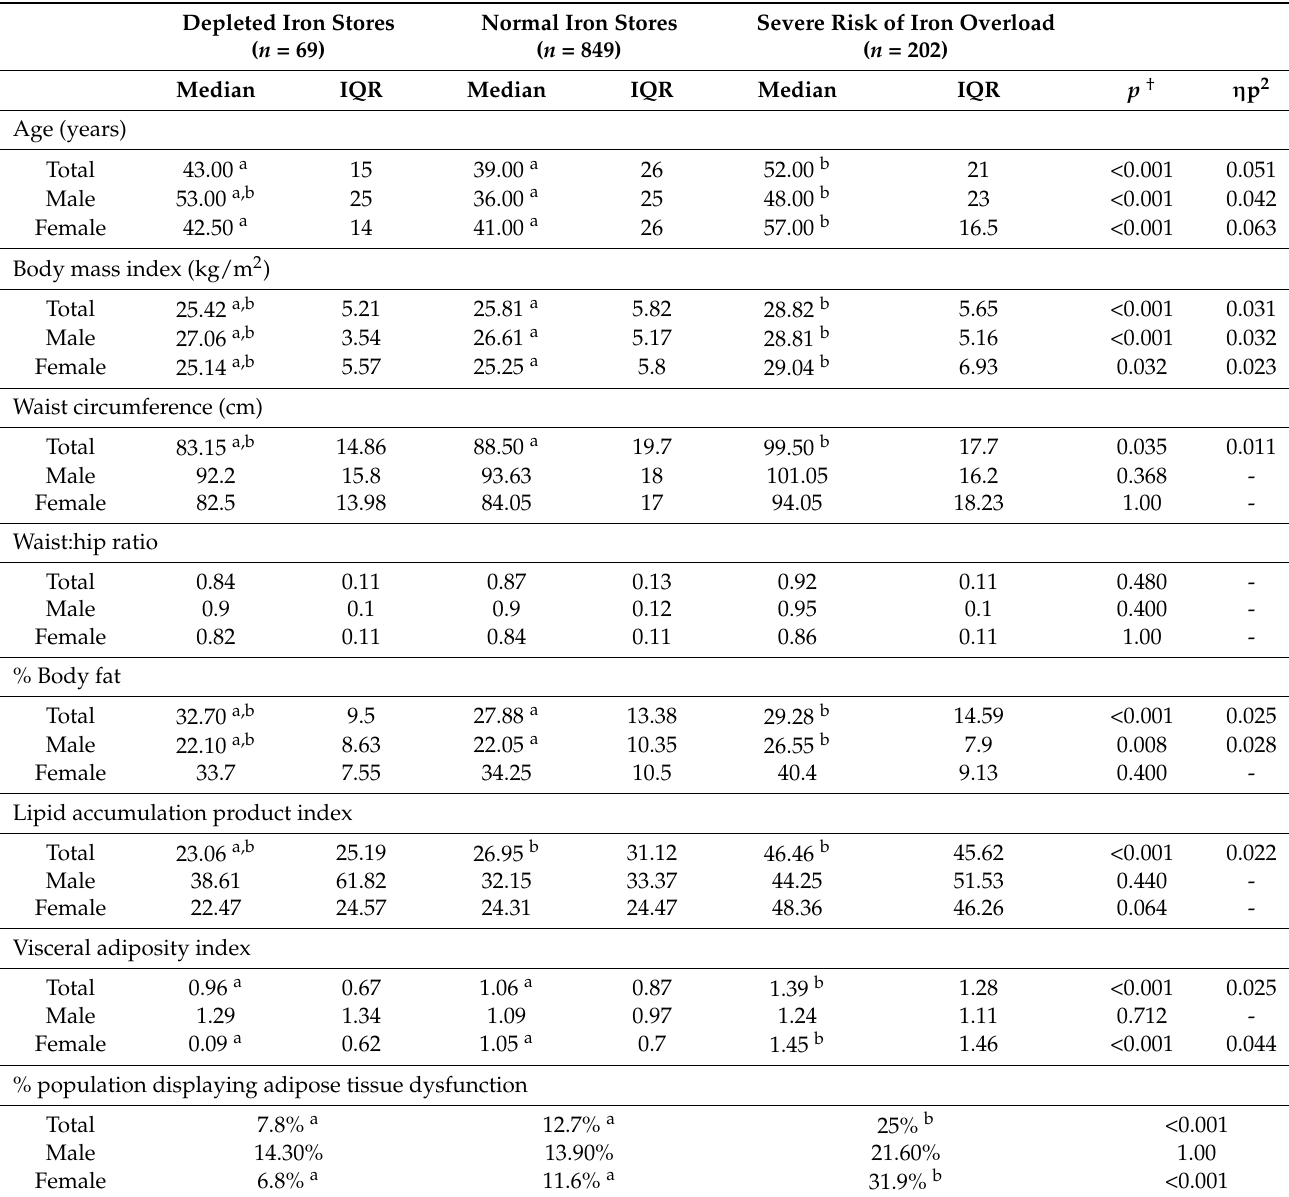
Table 1. Age and body composition characteristics of the population across categories of iron store status as determined by WHO serum ferritin